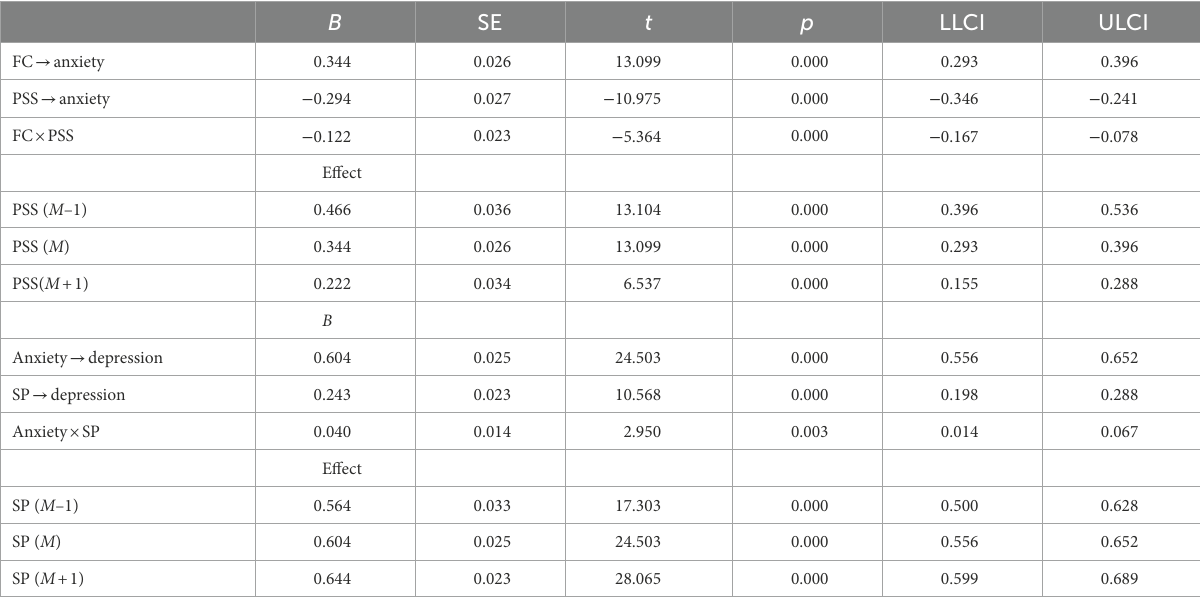
TABLE 5 Moderating effect test.